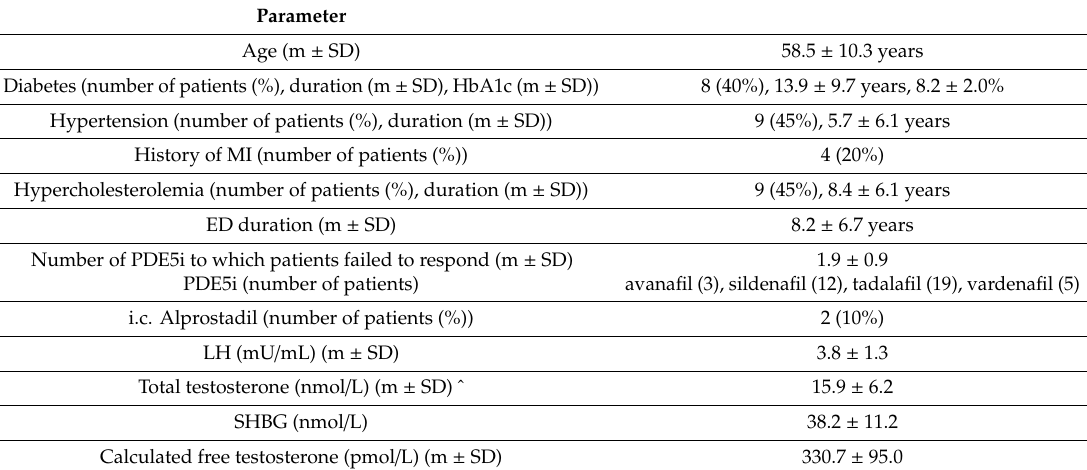
Table 1. Baseline characteristics of the 20